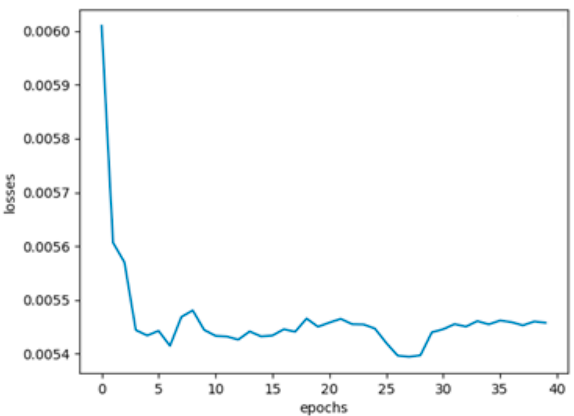
Figure 4. Reduction of losses for Intensified LSTM.